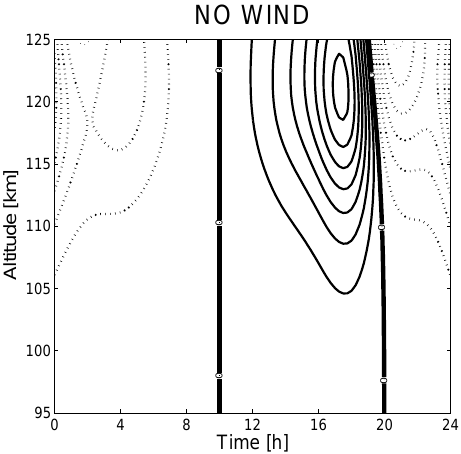
Fig. 3. Vertical velocity field for ions in the presence of the electric field; spacing interval 5m/s. Continuous/dotted lines represent pos- itive/negative velocities, corresponding to upward/downward move- ment. Zero lines are